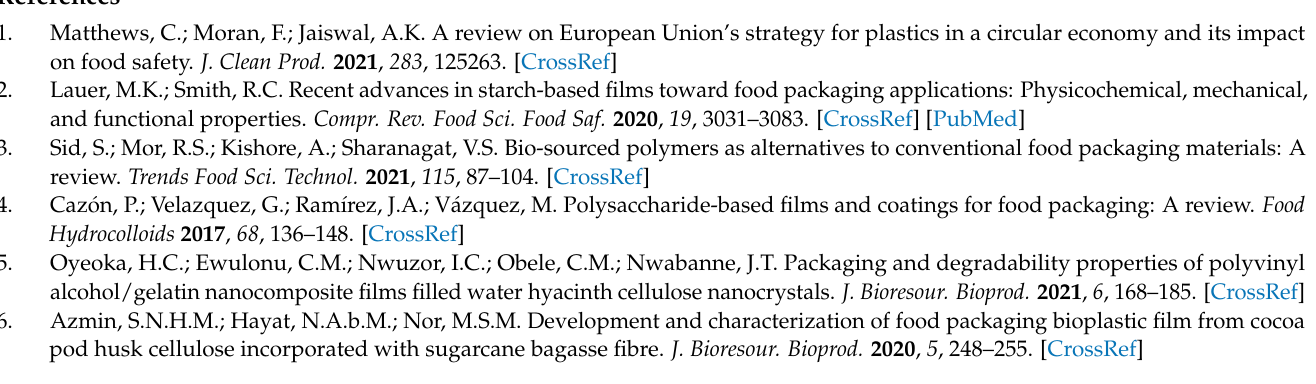
Table S2: TGA values at the second stage of thermal decomposition of starch films (control) and starch-based films containing 20% of commercial CaCO 3 , E. huxleyi (EHUX) or C. pseudoroscoffensis (CP); Figure S1: Real images of starch-based films without and with 2.5, 5, and 10% ( w/w of dry starch weight) of commercial CaCO 3 , E. huxleyi (EHUX) and C. pseudoroscoffensis (CP) biomass; Figure S2: Values (mean ± standard deviation) for lightness (L*), red-green (a*), yellow-blue (b*), and total colour variation ( ∆ E) of pristine starch films (control) and starch-based films containing commercial CaCO 3 , E. huxleyi (EHUX) or C. pseudoroscoffensis (CP). Different letters between each condition indicate significant differences (Student’s t-test; p < 0.05); Figure S3: a) TGA curves and b) first derivatives of starch films; Figure S4: Weight loss percentage observed after immersion in water for 8 days of pristine starch films (control) and starch-based films containing commercial CaCO 3 , E. huxleyi (EHUX) or C. pseudoroscoffensis